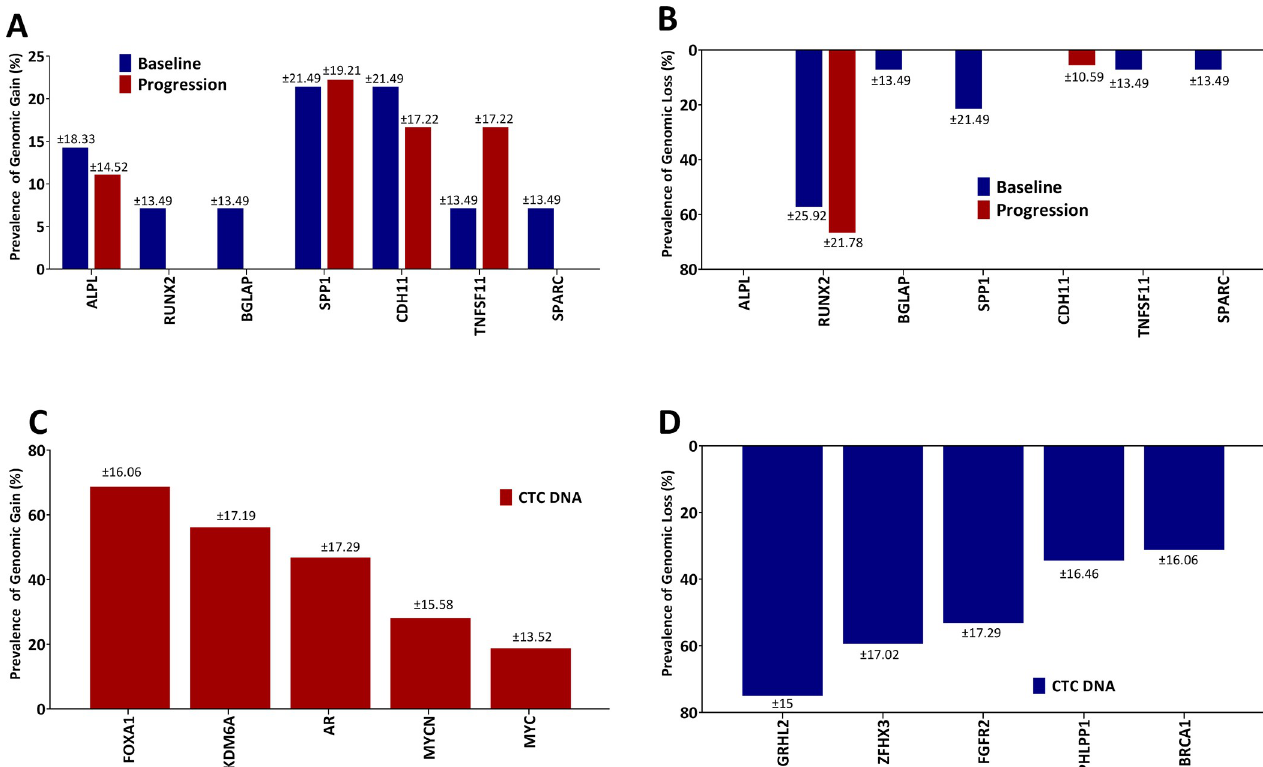
Fig 4. Copy number analysis of osteomimicry genes including A . Copy gain, and B. Copy loss in CTCs from men with mCRPC treated with radium-223. In addition, top five prevalent genomic alterations by copy gain and loss are shown in C ( Red bars) and D (Blue bars), respectively. ALPL: bone alkaline phosphatase (ALPL), RUNX2: Runt Related Transcription Factor, BGLAP: Bone Gamma Carboxyglutamate Protein, SPP1: Osteopontin, CDH11: OB-Cadherin, TNFSF11: Tumor necrosis superfamily member, SPARC: Secreted Protein Acidic and Cystein Rich.